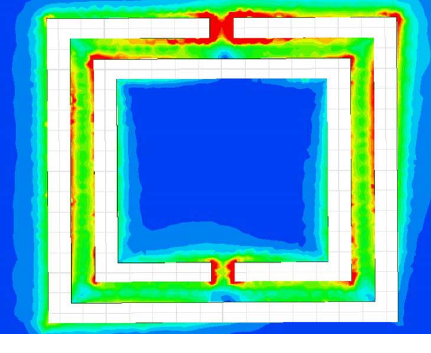
Figure 11. Simulated current surface distribution on a 3 -mm CSRR at the resonance frequency.